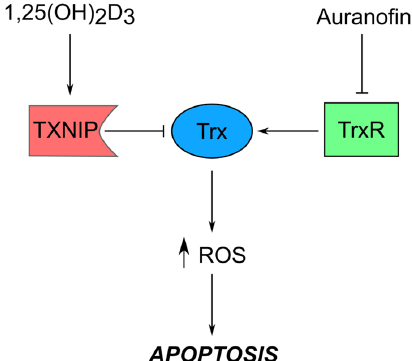
Figure 2. Potential cooperative targeting of the thioredoxin system by 1,25(OH) 2 D 3 and auranofin. Induction of thioredoxin ‐ interacting protein (TXNIP)/ vitamin D3 ‐ upregulated protein 1 (VDUP1) expression with 1,25(OH) 2 D 3 and inhibition of thioredoxin reductase (TrxR) by auranofin and other gold complexes could synergistically inhibit the reductive capacity of the thioredoxin (Trx) system, subsequently increasing intracellular reactive oxygen species (ROS) levels, which activate apoptotic signaling. Besides influencing redox balance, 1,25(OH) 2 D 3 ‐ mediated TXNIP induction may alter glucose homeostasis given the latter’s role in regulating intracellular glucose levels. Although this effect is independent of other players of the Trx system (hence not presented in figure), it could define novel anti ‐ tumor roles of 1,25(OH) 2 D 3 .